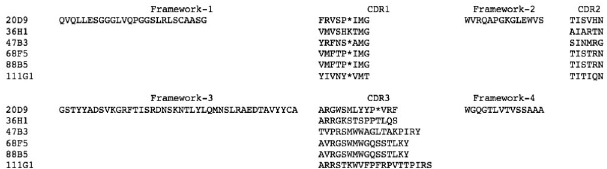
Fig 5. Amino acid sequence alignment of the six positive clones. The CDRs and framework of the variable domains are indicated. The amber codon is marked by ( � ).